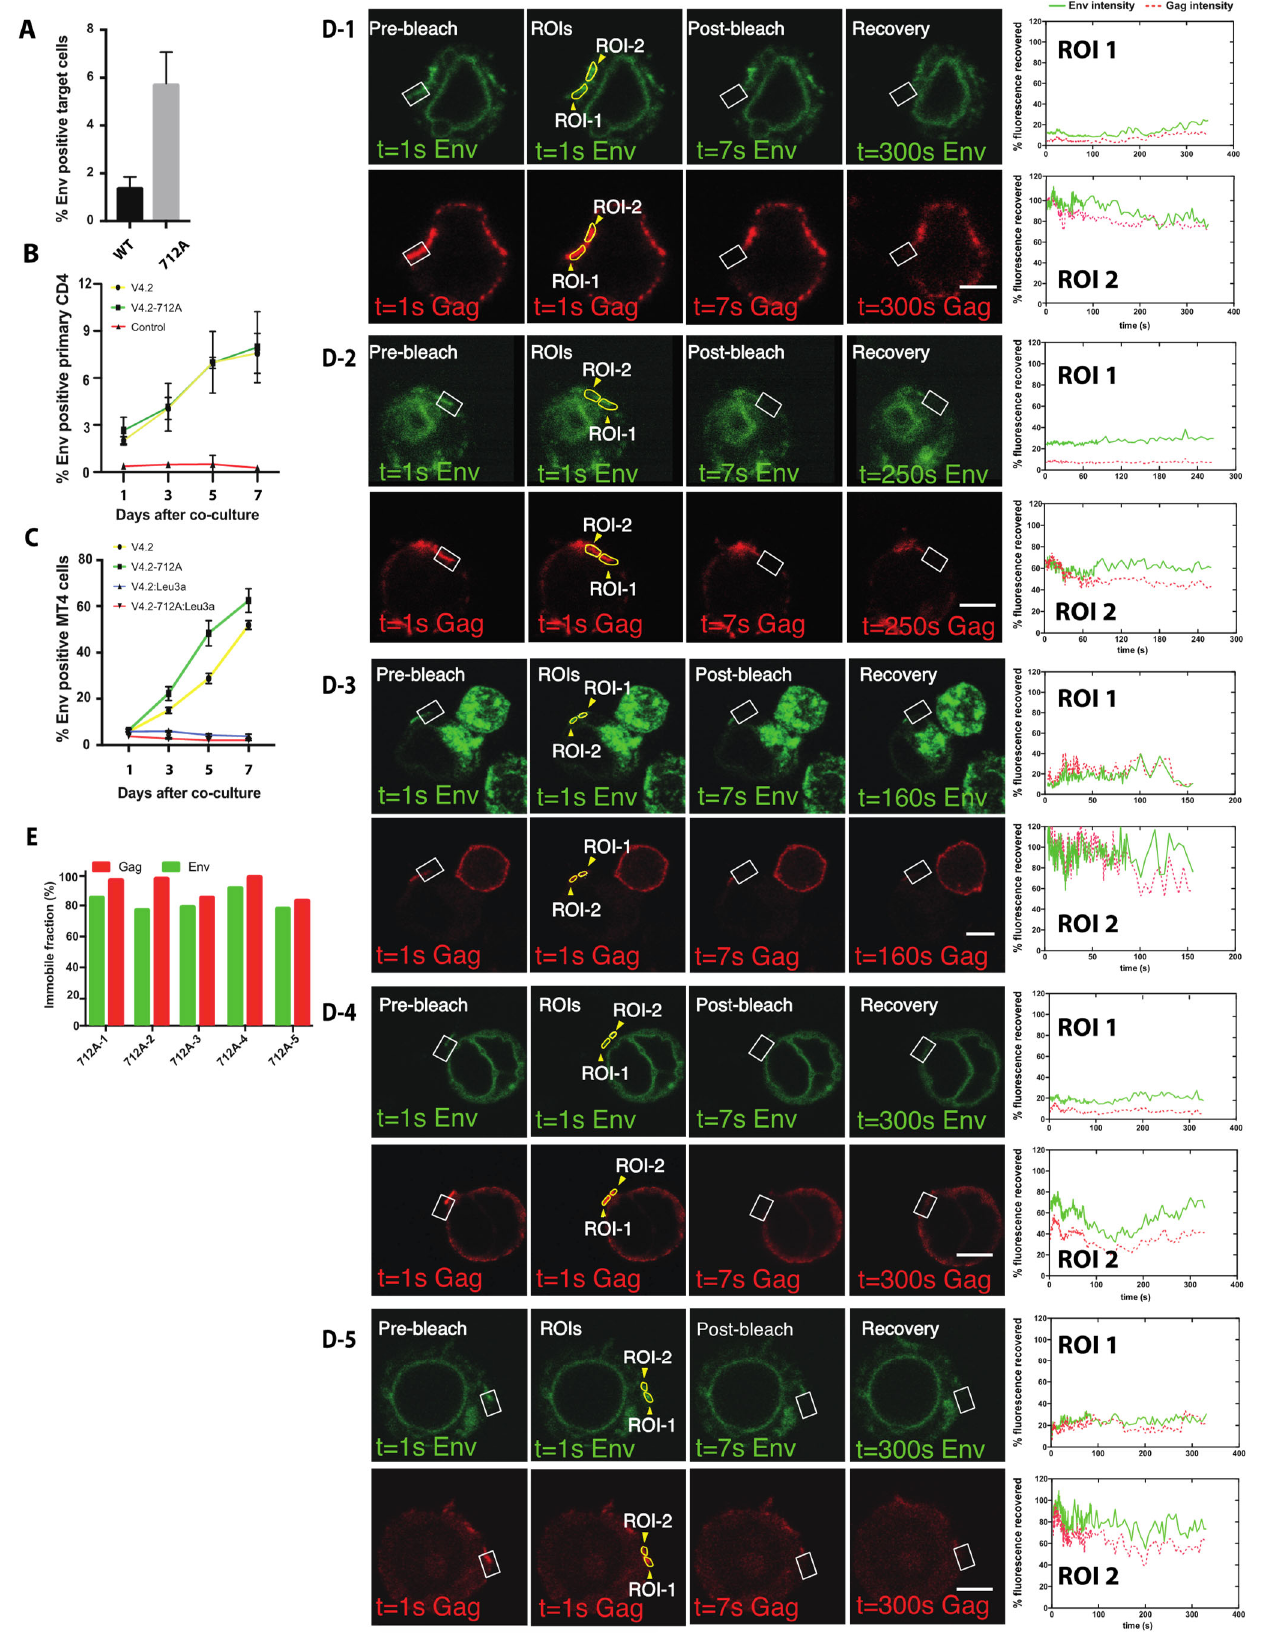
Figure 6. Env fluorescence after photobleaching does not recover when examining Y712A mutants